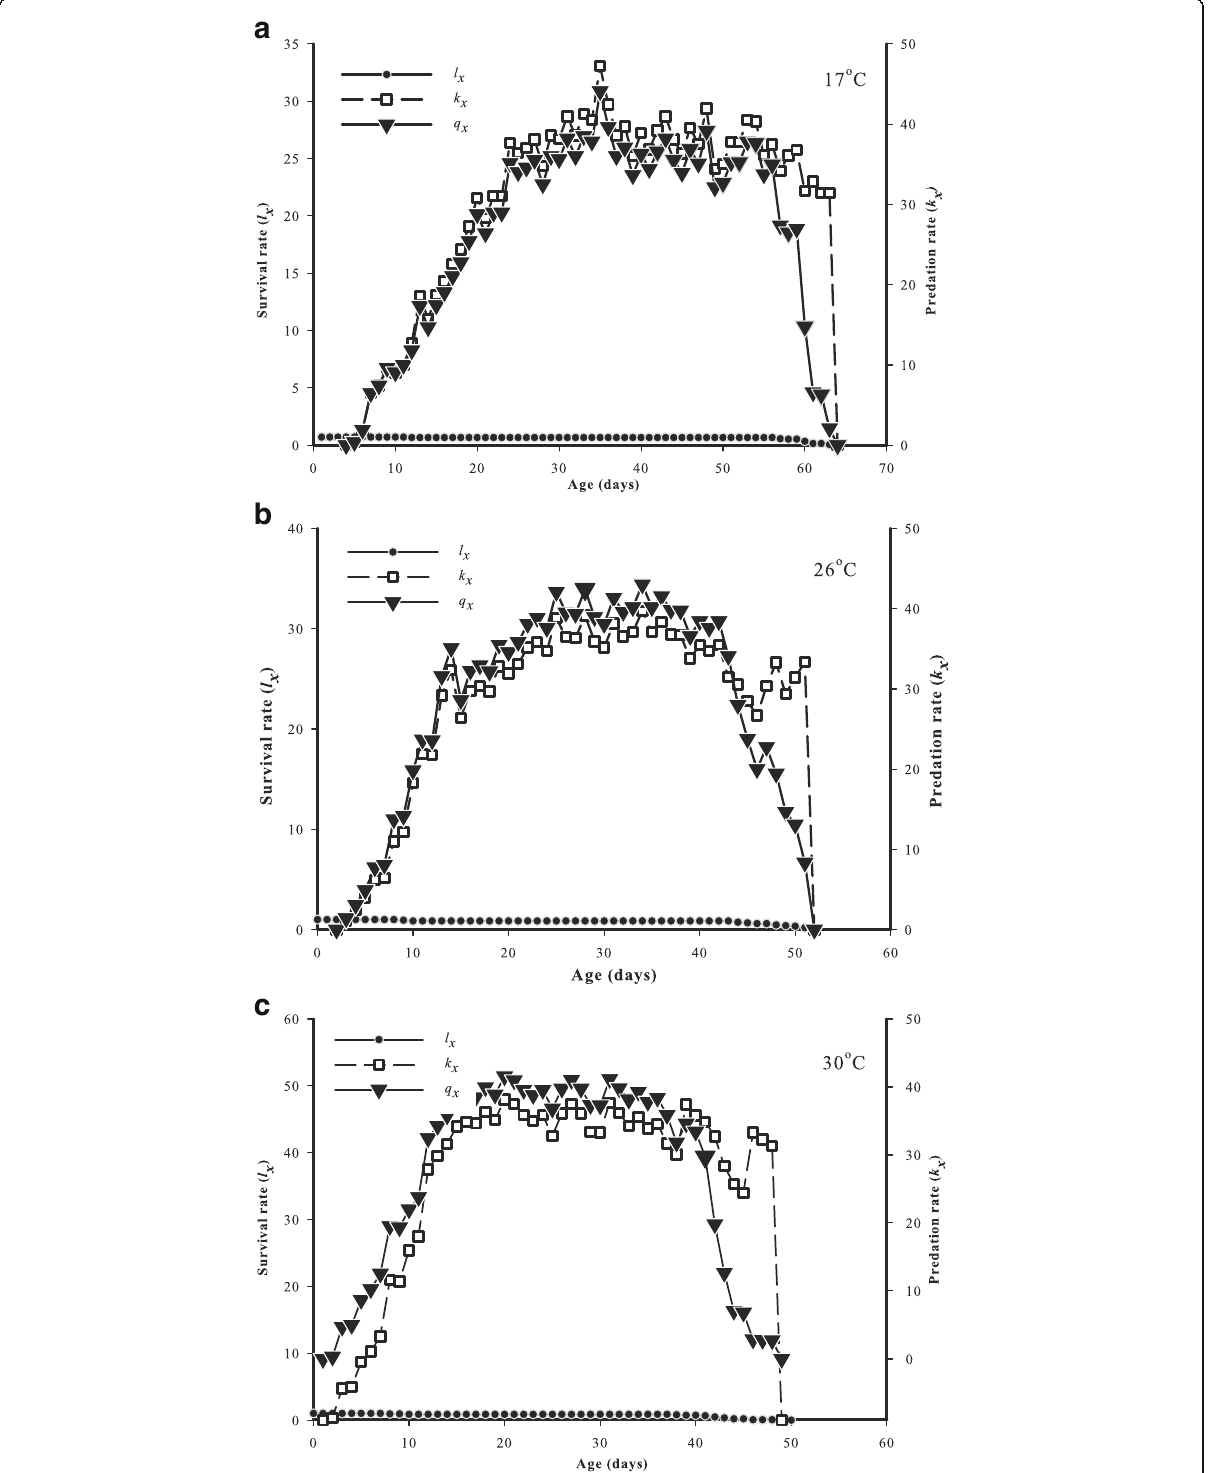
Fig. 1 Age-specific survival rate ( l x ), age-specific predation rate ( k x ), and age-stage-specific net predation rate ( q x ) of Anthocoris minki pistaciae fed with Agonoscena pistaciae at three different temperatures under laboratory conditions. l x , the age-specific survival rate; k x , the age-specific predation rate; and q x , the age-stage-specific net predation rate ( l x k x ) of Anthocoris minki pistaciae feeding on Agonoscena pistaciae nymphs at three different temperatures. a 17 °C. b 26 °C. c 30